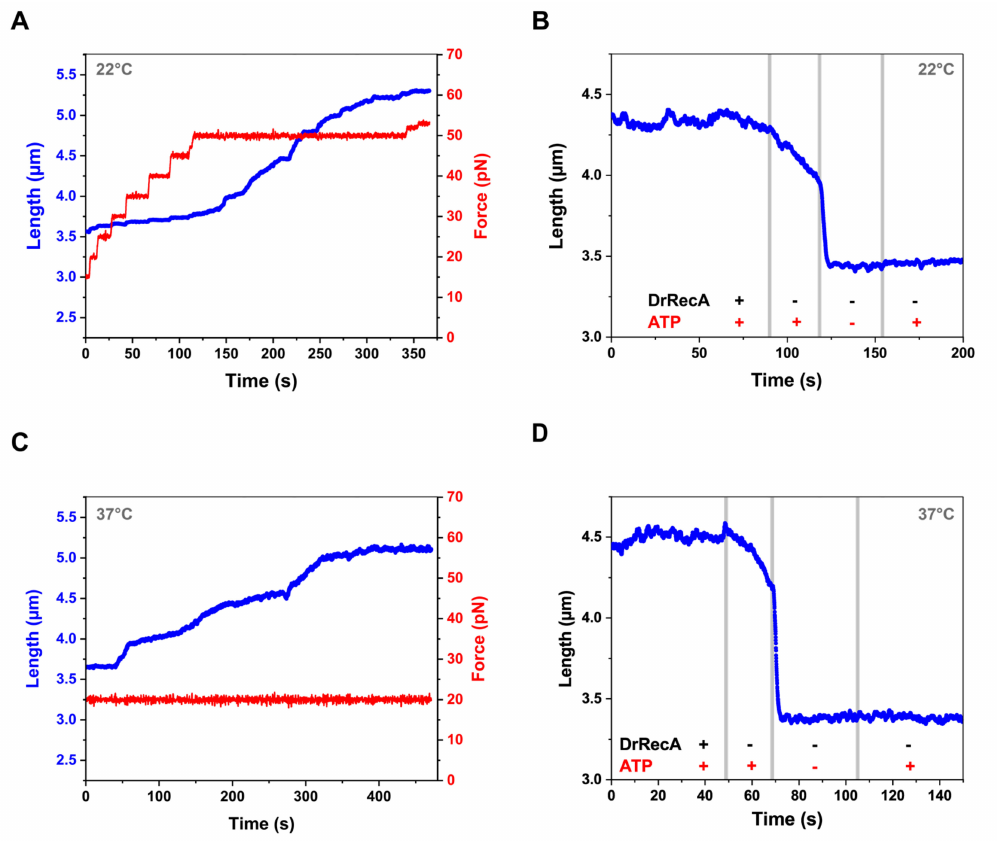
Figure 3. Dynamics of DrRecA–dsDNA filaments length. ( A ) dsDNA elongation upon DrRecA binding at 22 ◦ C (polymerization was observed when applied force was 50 pN or higher). ( B ) Shortening of the DNA tether due to DrRecA dissociation from dsDNA while transferred first into the ATP-containing bu ff er without free DrRecA, and then in the ATP-free bu ff er under stretching force of 3 pN at 22 ◦ C. Subsequent reintroduction back to the ATP-containing solution does not alter the DNA length. Gray vertical lines indicate moments the DNA tether was transferred between corresponding channels. ( C ) dsDNA elongation upon DrRecA binding at 37 ◦ C and 20 pN stretching force. ( D ) same as ( B ) but at 37 ◦ C. dsDNA: double-stranded